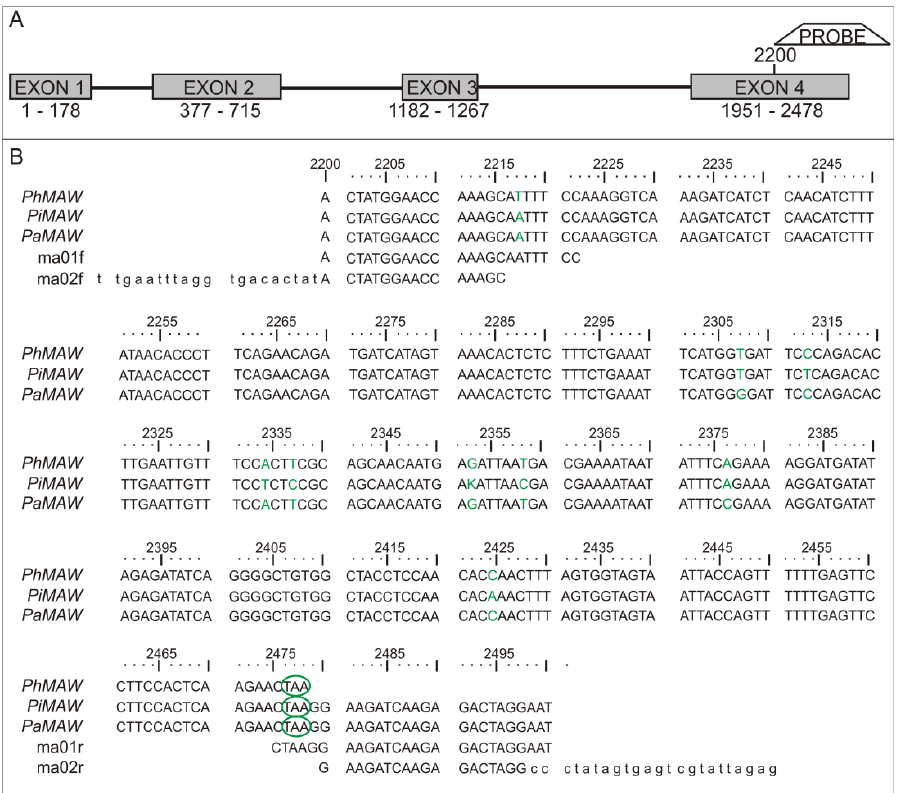
Figure 2. MAWEWEST (MAW) gene structure and alignment. ( A ) Gene structure and probe position in Petunia × hybrida ; ( B ) MAW gene alignment. The numbers in A – B represent the base pair position in relation to the +1 frame. PhMAW is Petunia × hybrida MAW gene; PiMAW is Petunia inflata MAW gene; PaMAW is Petunia axillaris MAW ; ma01f and ma01r refer to the first primer pair used; ma02f and ma02r refer to the second primer pair. Single nucleotide polymorphisms are represented in green, and green circles signify stop